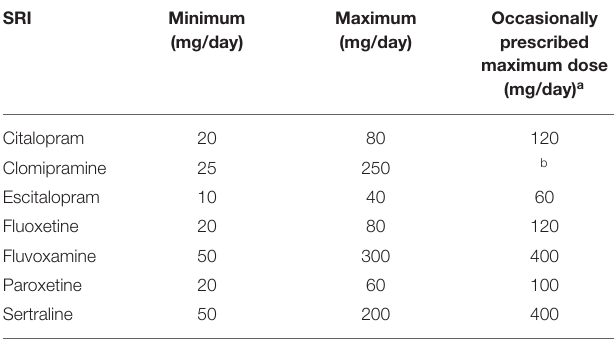
TABLE 2 | Dosing of serotonin reuptake inhibitors in